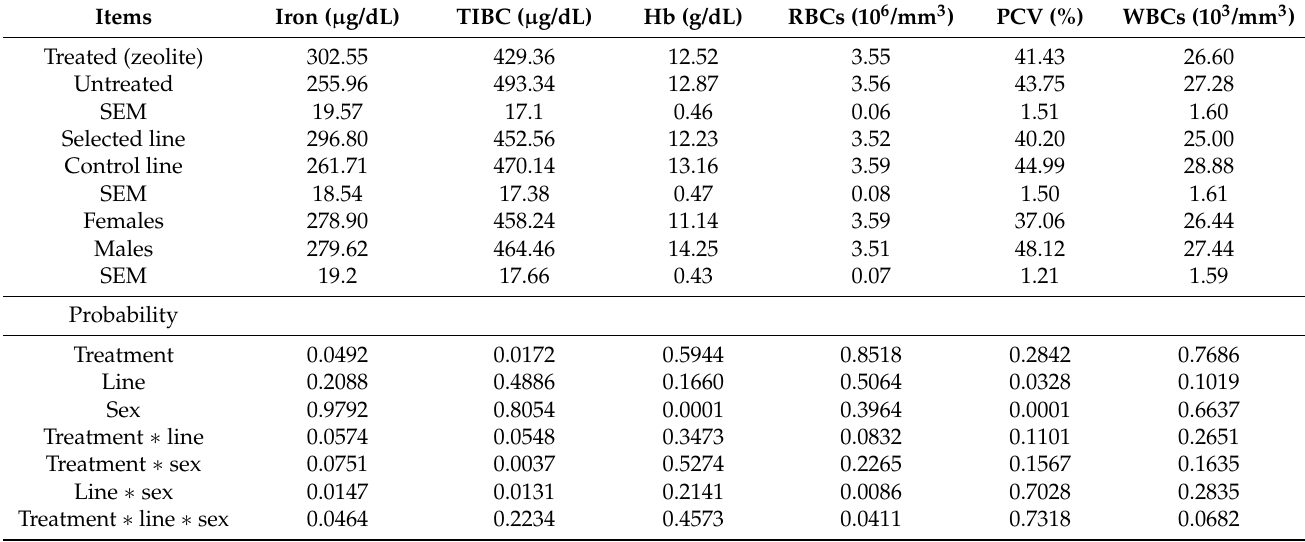
Table 6. Least square means for iron profile and hematological parameters as affected by treatment, line, and sex effects.